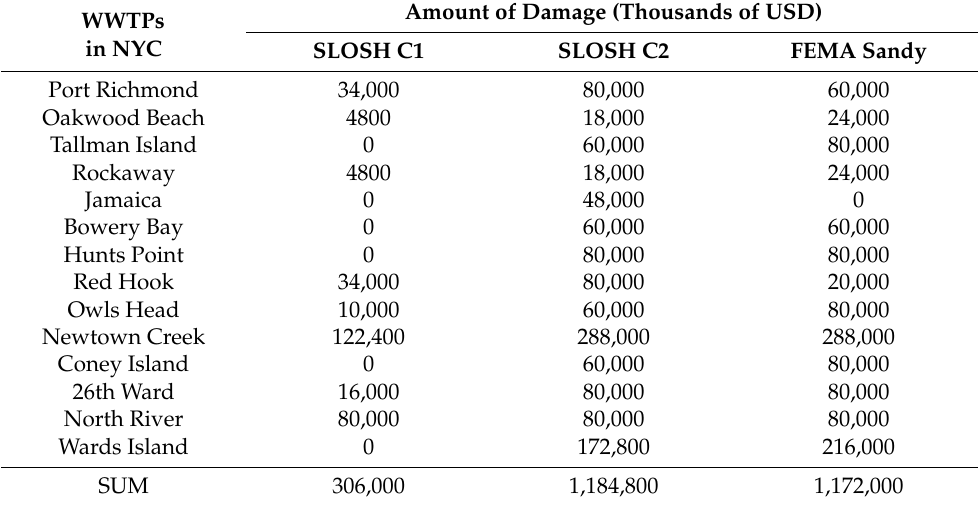
Table 6. Comparison of the amount of damage related to the FEMA MOTF Sandy, SLOSH C1, and C2